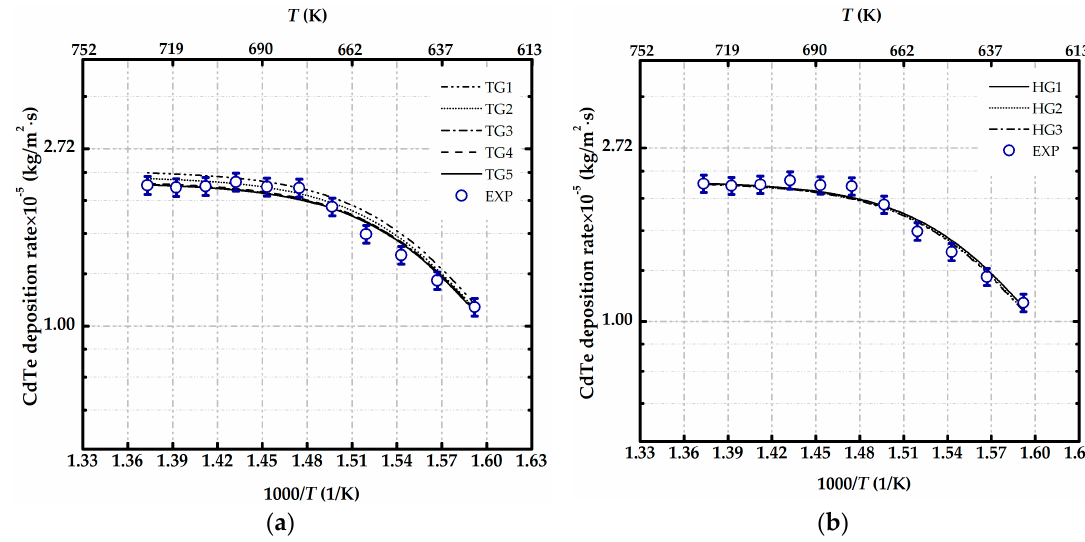
Figure 4. Comparisons of experimental data and 3D simulation prediction of CdTe deposition rate by using different types of grid: ( a ) tetrahedral grid (TG); ( b ) hexahedral grid (HG). using di ff erent types of grid: ( a ) tetrahedral grid (TG); ( b ) hexahedral grid